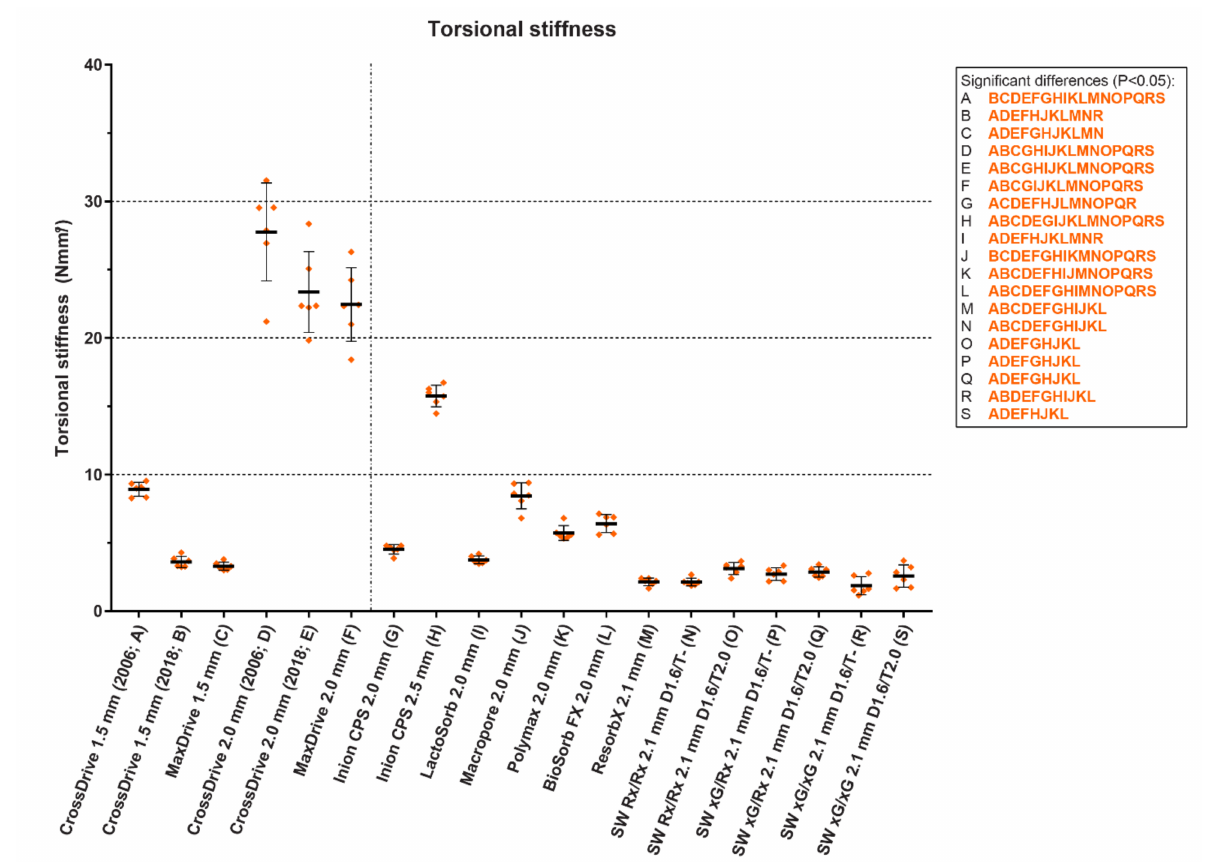
Figure 9. The torsional stiffness of 13 biodegradable and 6 titanium osteosynthesis systems commonly used in oral and maxillofacial surgery. The characters in blue and orange represent significant pairwise differences in maximum load and stiffness, respectively, between the corresponding systems using a one-way analysis of variance adjusted for multiple testing. The titanium CrossDrive (2006) plates consisted of 100% titanium produced by stamping of plates. The titanium CrossDrive (2018) and MaxDrive consisted of 100% titanium produced by milling of plates. The titanium CrossDrive (2006 and 2018) and MaxDrive screws consisted of a Ti6Al4V alloy. The composition of each biodegradable system is described in Table 1. Error bars: mean values ± standard deviation. Ti6Al4V, 90% titanium, 6% aluminum and 4% vanadium alloy; SW, SonicWeld; D, drill diameter (mm); T, tap diameter (mm). The dotted line separates the titanium (left) and biodegradable systems (right). Reprinted with permission from